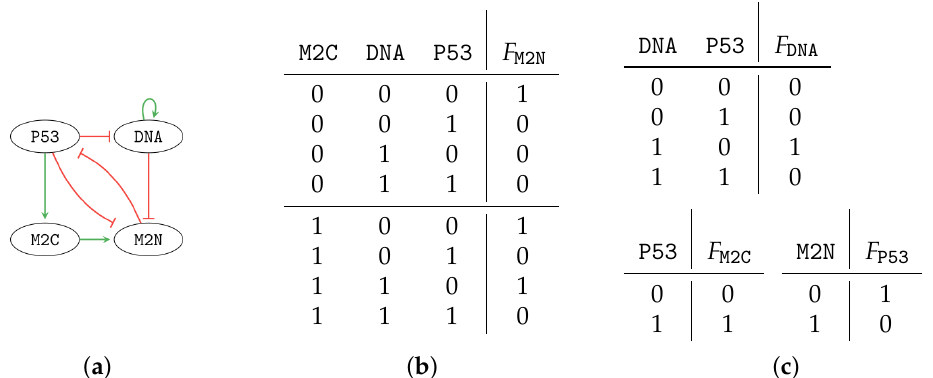
Figure 1. ( a ) A regulatory network of a simple BN describing the DNA damage mechanism adapted from [2]. Every regulation is either activating (green) or inhibiting (red) and observable. ( b ) Update function F M2N . ( c ) Update functions F DNA , F M2C and F P53